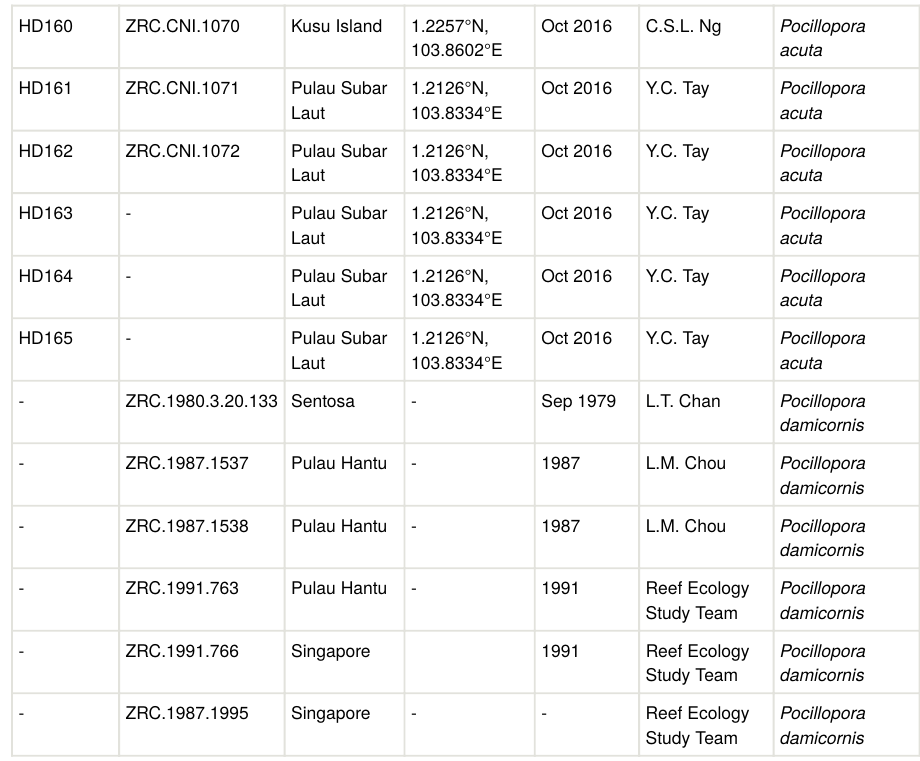
Description . Colonial, densely caespitose (Fig. 1A, D, G, J, M); branches typically round in cross section, but may become fl attened at the tips, which are usually sharply pointed. Branches of colonies in exposed sites thicken and have smaller spacing between branches (Fig. 2A–F), while those in sheltered sites are elongate and slender (Fig. 2G–L). Calices typically oval, with the small diameter ranging between 0.6 and 0.8 mm, and the large diameter between 1.0 and 1.2 mm. Columellae fl at. Septa poorly developed, in two equal cycles; 12 septa per corallite (Fig. 1L, O). Coenosteum with fi ne spinules. Living colony pale-greenish in colour with characteristic darker pigmentation surrounding oral opening of polyps (Fig.